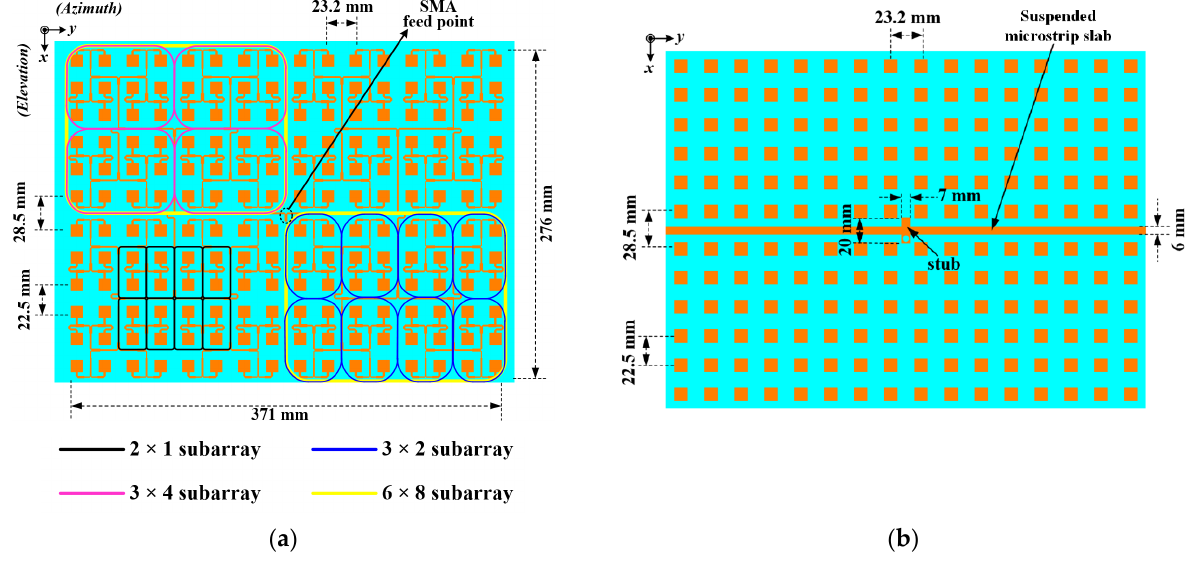
Figure 4. Configuration of the developed 12 × 16 array antenna showing ( a ) the middle layer M2 printed on the lower substrate and ( b ) the top layer M1 residing on the bottom side of the upper